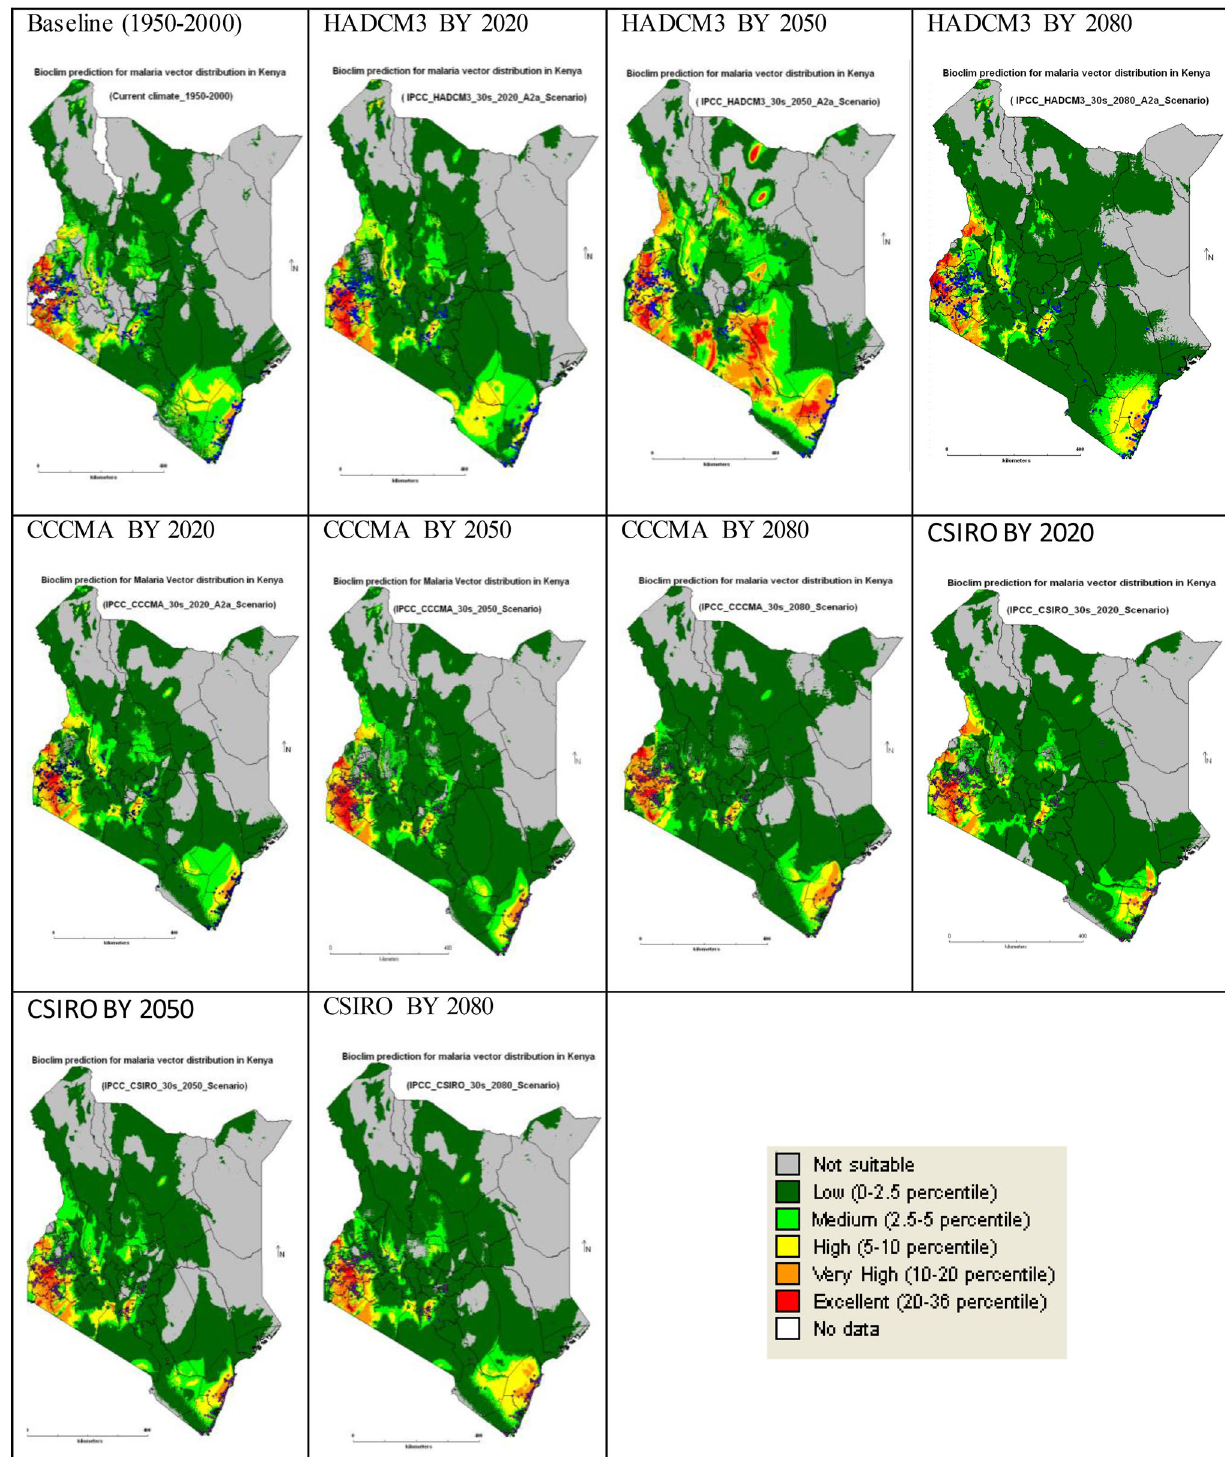
while red is the areas of excellent suitability with the other classes shown as low, medium, high and very high suitability as described in the different